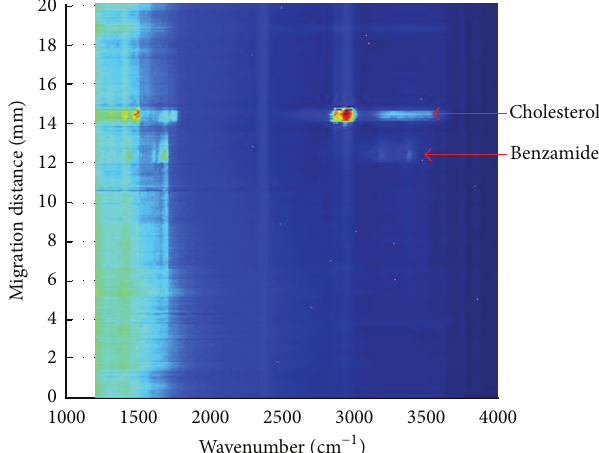
Figure 2: 3D chromatograph to characterize the distribution of the cholesterol and benzamide spots on a narrowband TLC plate.